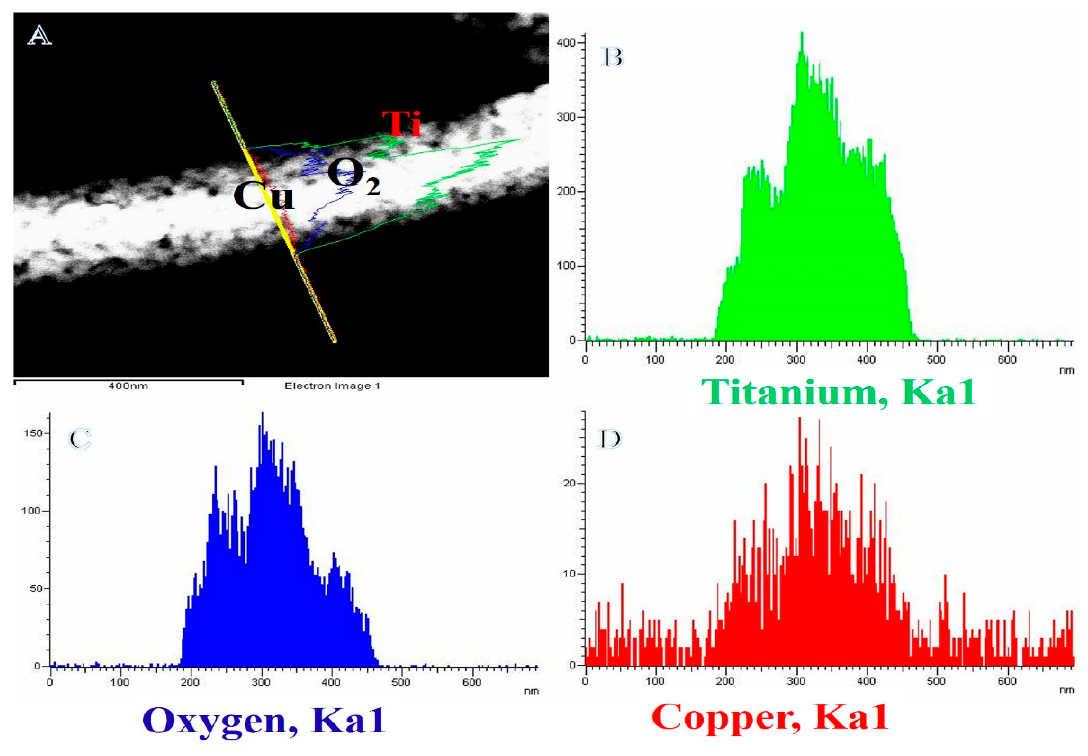
Figure 3. ( A ) STEM image along with the line EDX analysis of the produced powder after the hydrothermal process; ( B – D ) indicate line analysis EDX for the line shown in ( A ).